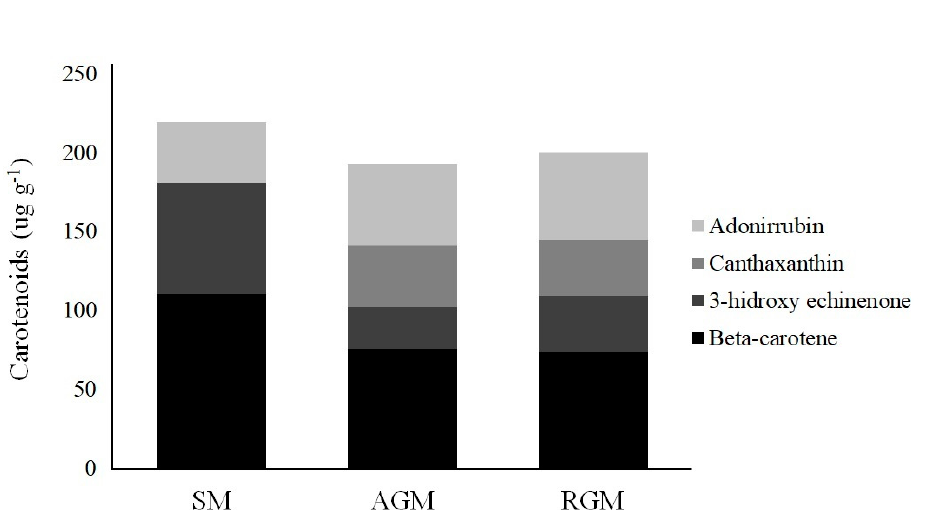
Figure 3. Carotenoid pigment profile of the NCYC1146 strain acquired from the total biomass produced from each of the bioprocesses carried out in the culture media SM, AGM and RGM at 15 °C. The results are shown in μ g g − 1 .